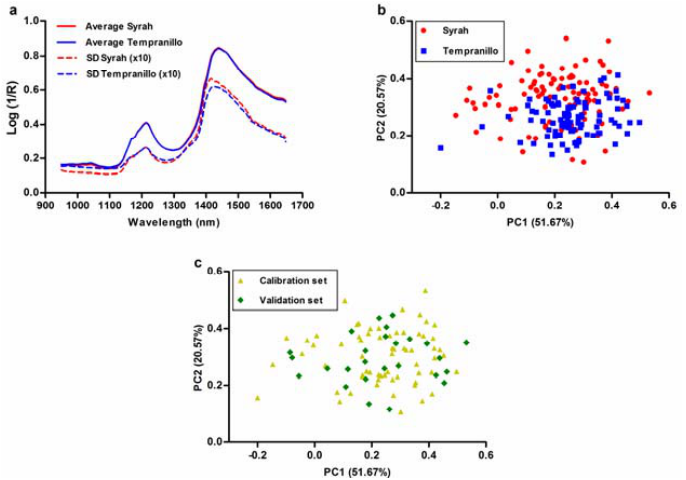
Figure 2. Description of near infrared spectra. ( a ) Near infrared average raw spectra and standard deviations (10 times amplified) for Syrah and Tempranillo samples. ( b ) Scores of the grape samples in the space defined by the first and second PCs. ( c ) Scores of the calibration and validation samples in the space defined by PC1 and PC2.